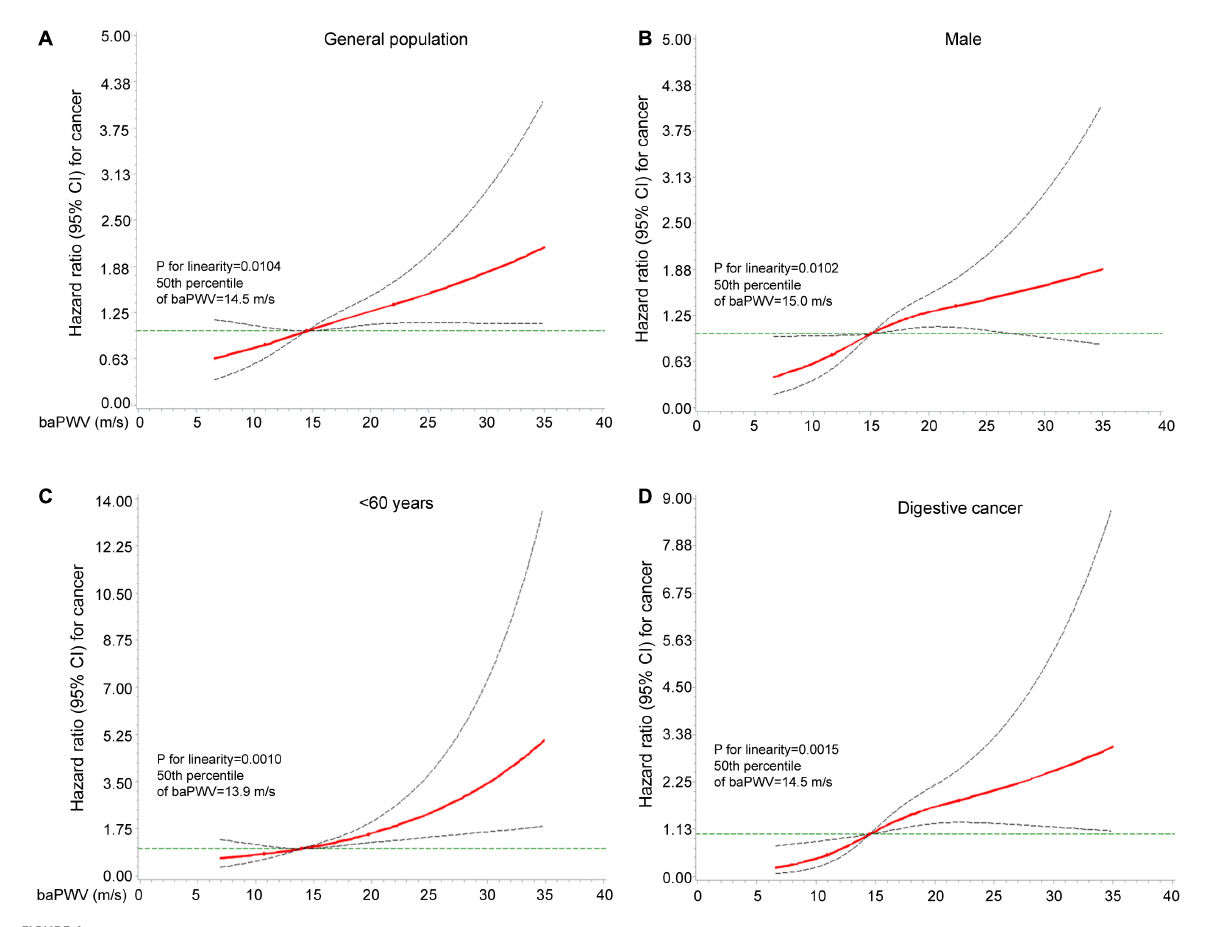
FIGURE4 Risk of cancer according to restricted spline curve. Spline-curve analyses show a linearly increasing risk, linking the severity of arterial stiffness to overall cancer risk in the entire cohort (A) men (B) and participants < 60-year-old (C) . Spline-curve analyses show a linearly increasing risk, linking the severity of arterial stiffness to digestive cancer risk in the entire cohort (D) . Hazard ratios of restricted cubic spline transformation of baPWV with 3 knots (5, 50, and 95% of baPWV value) and 50% of baPWV value as a reference are plotted. Red lines are hazard ratios and gray lines are 95% confidence intervals. baPWV, Brachial-ankle pulse wave